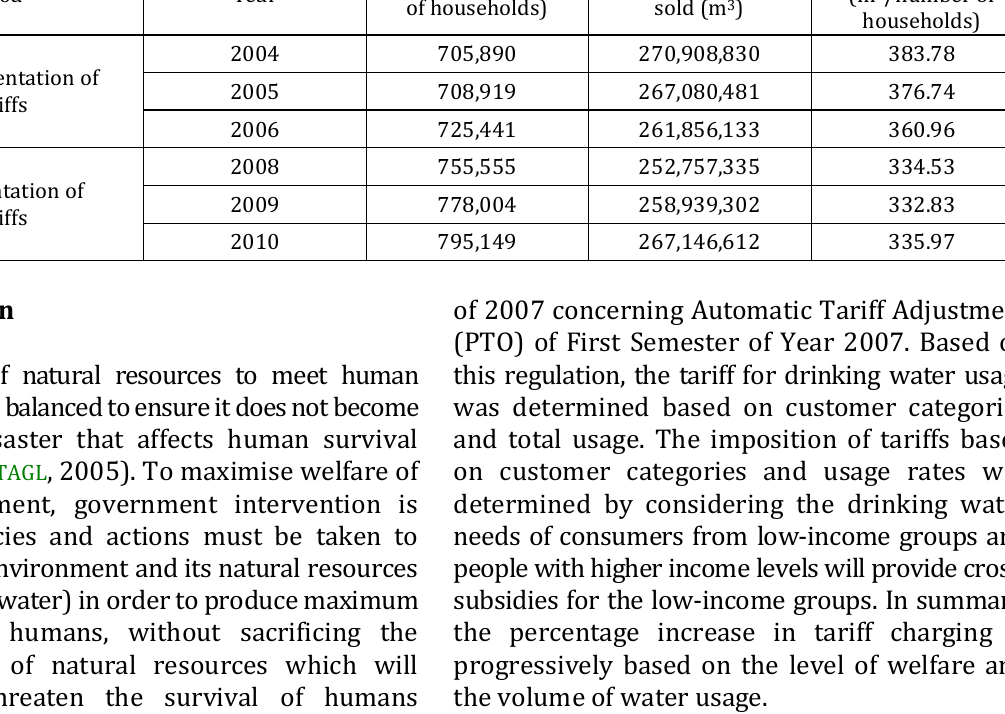
Table 6. Number of customers and water use before and after the implementation of progressive tariffs in Jakarta Customers (number Period Year of households)